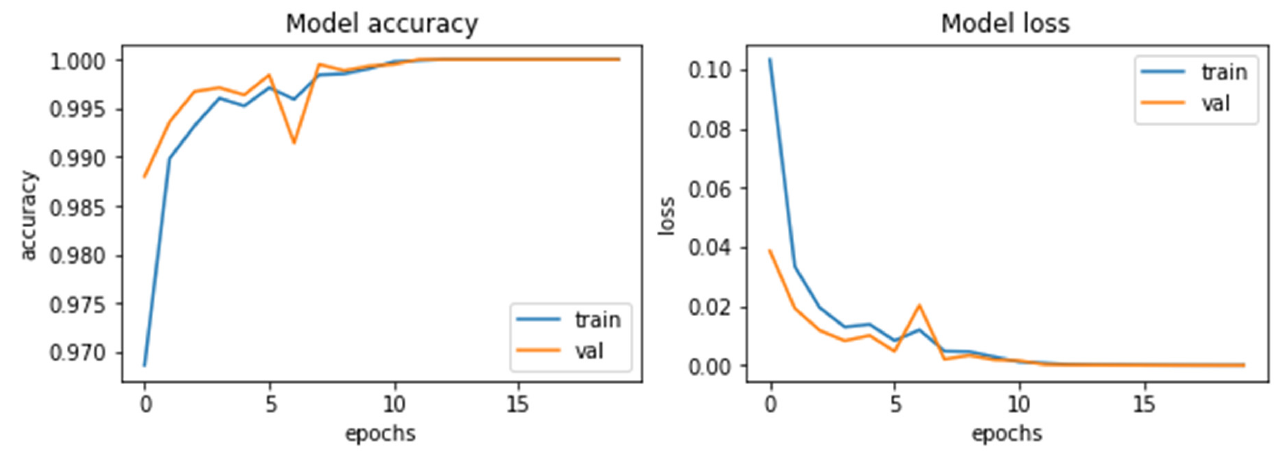
Figure 17. Accuracy and loss curves of Xception architecture.